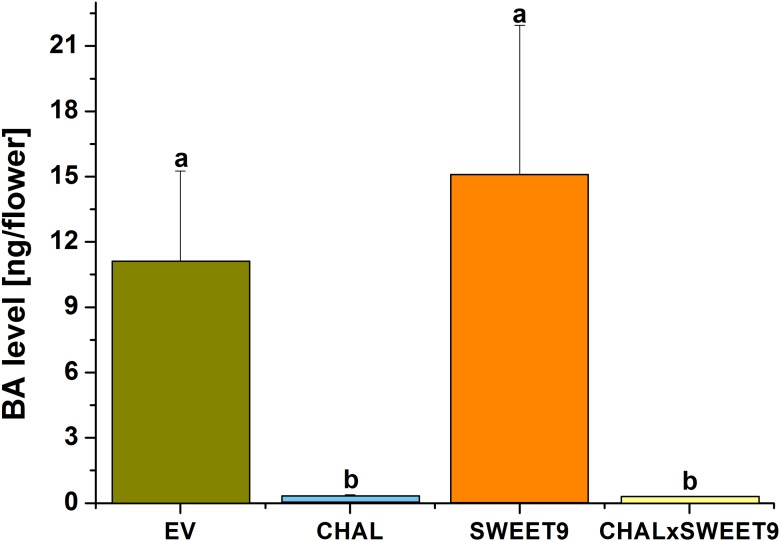
Analysis of flower volatiles.Benzylacetone (BA) level from flowers in the field during the first night of opening (bars represent mean +SE amount of BA trapped per flower, n = 8). Different letters indicate significant differences, as informed by Friedman signed rank test p < 0.05.